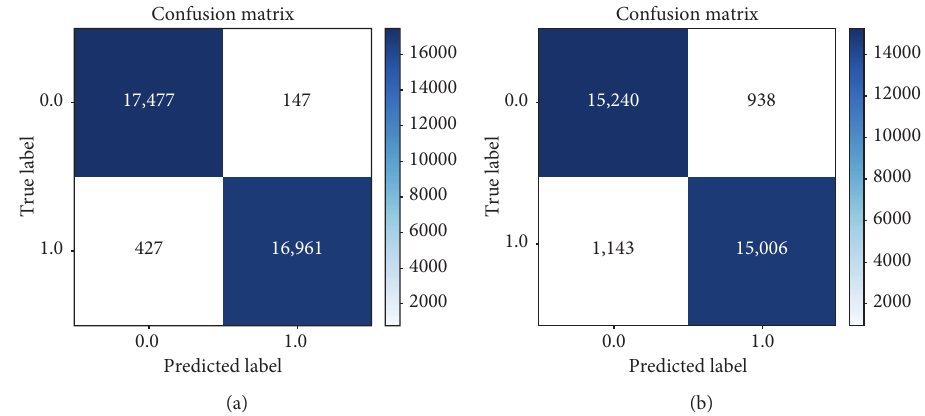
Figure 7: Confusion matrix by deep neural network in making predictions of suicide and success. (a) Confusion matrix of suicide in deep neural network. (b) Confusion matrix of success in deep neural network.